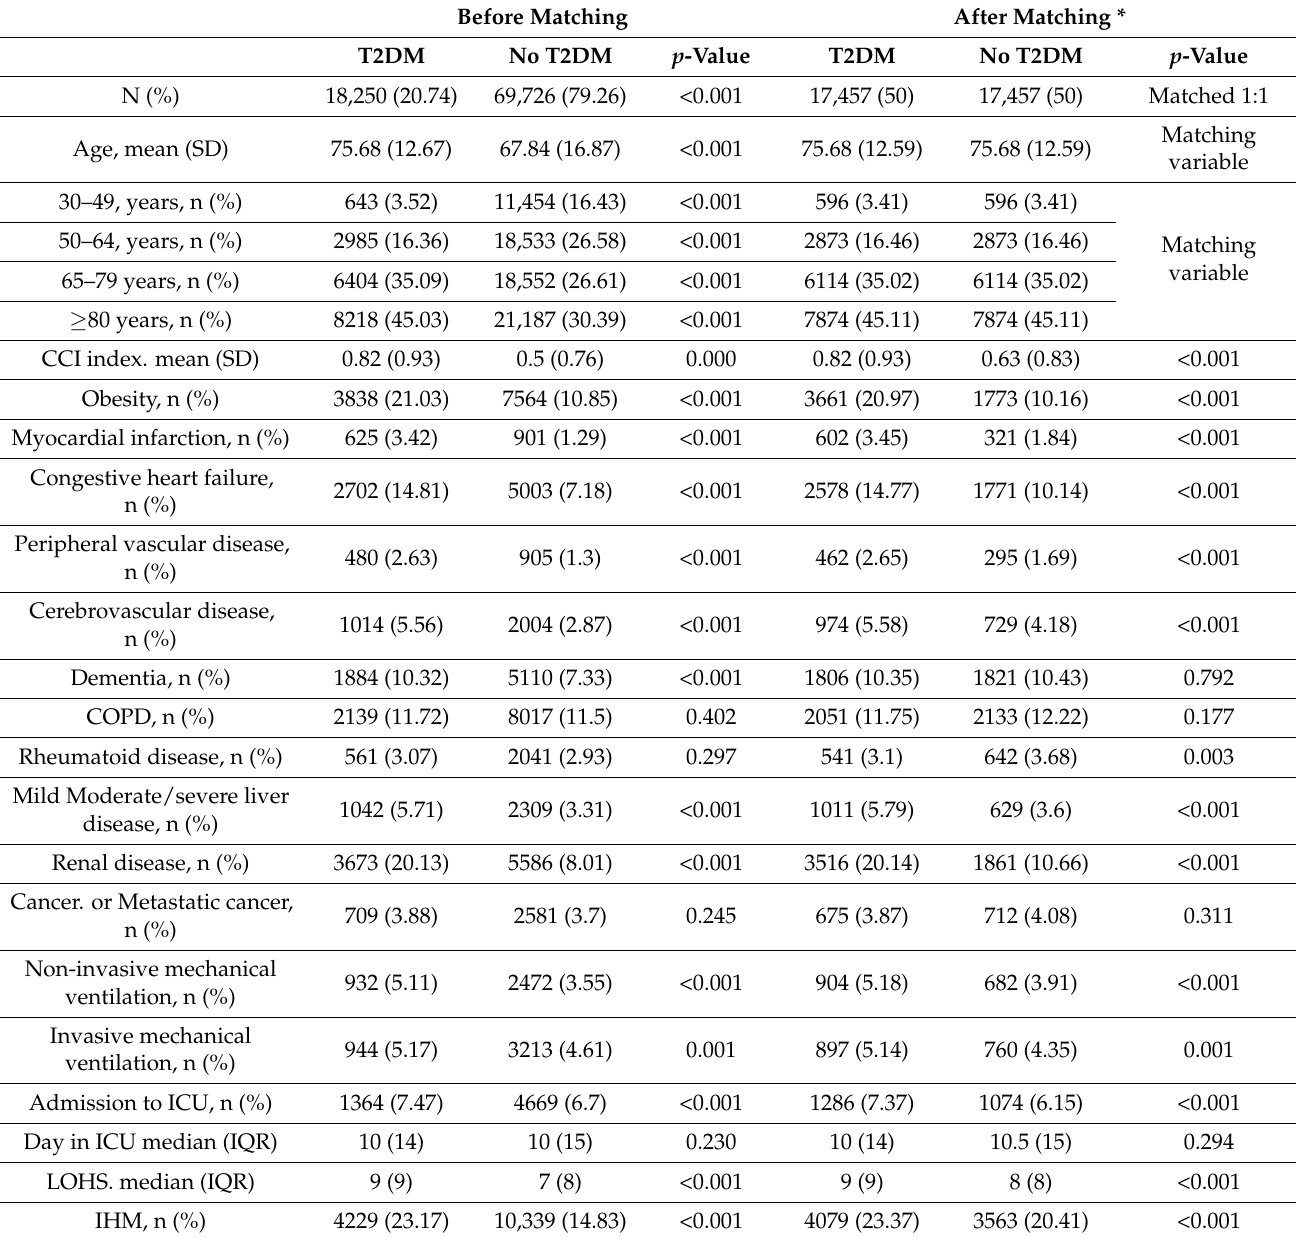
Table 2. Distribution of study covariates and hospital outcomes, before and after matching, for women hospitalized for COVID-19 in Spain in the year 2020 according to T2DM